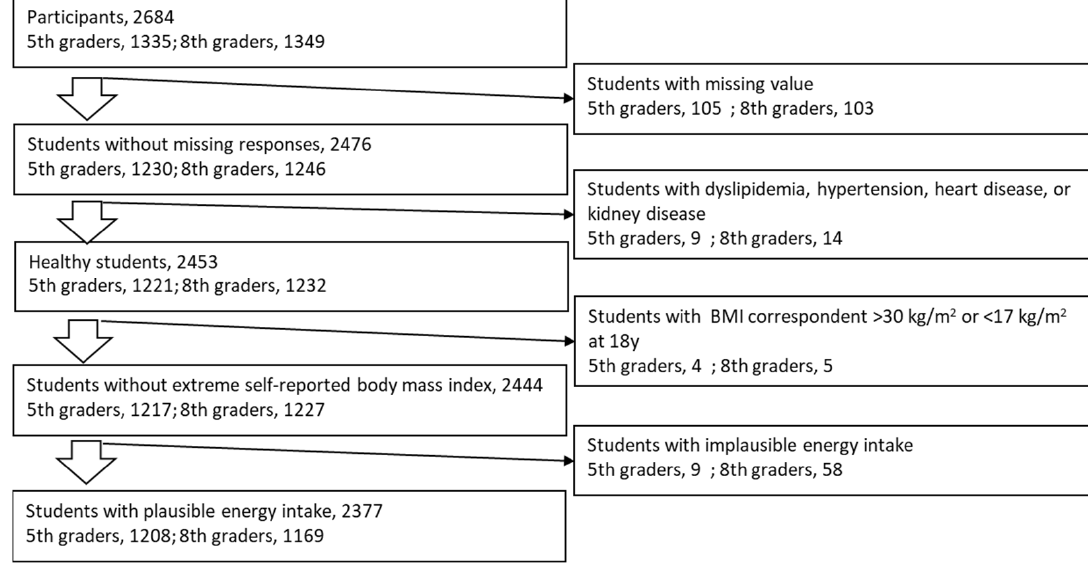
Figure 1. Subject